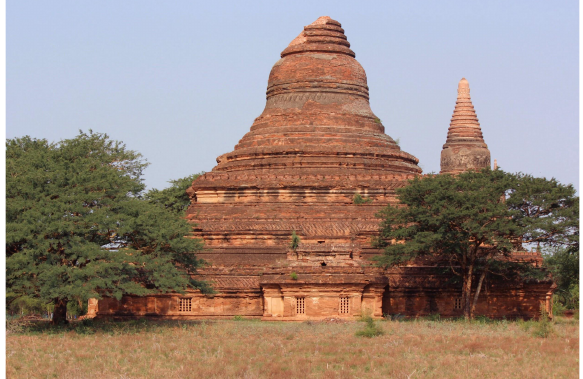
Figure 1. Myin-pya-gu temple, Old Bagan,